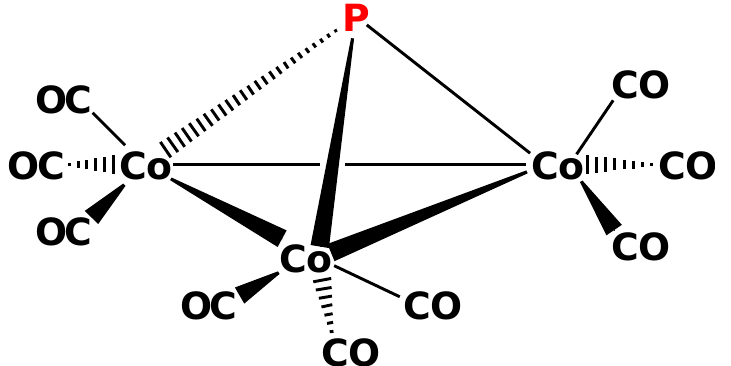
Figure 4. Schematic view of the structure of complex 6 [29].